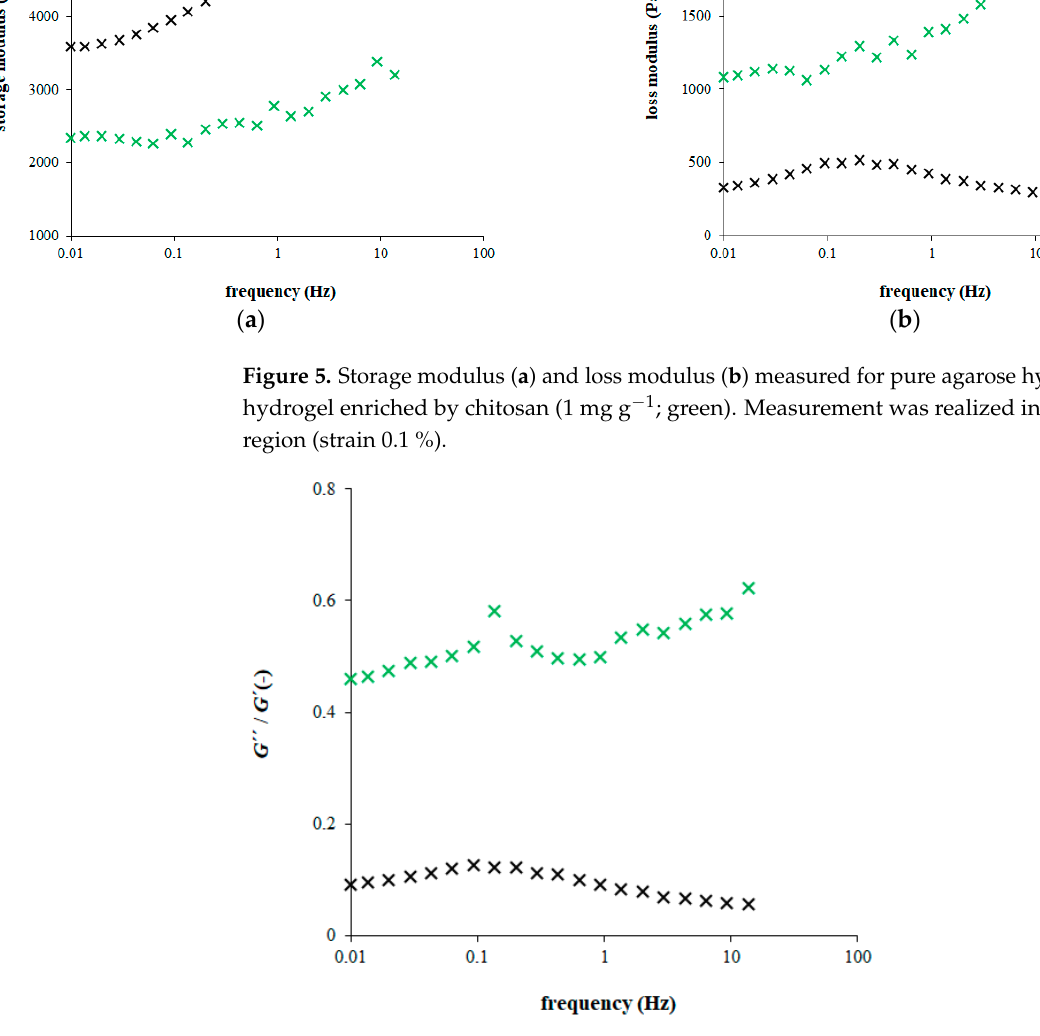
Figure 5. Storage modulus ( a ) and loss modulus ( b ) measured for pure agarose hydrogel (black) and hydrogel enriched by chitosan (1 mg g − 1 ; green). Measurement was realized in linear viscoelastic region (strain 0.1 %).